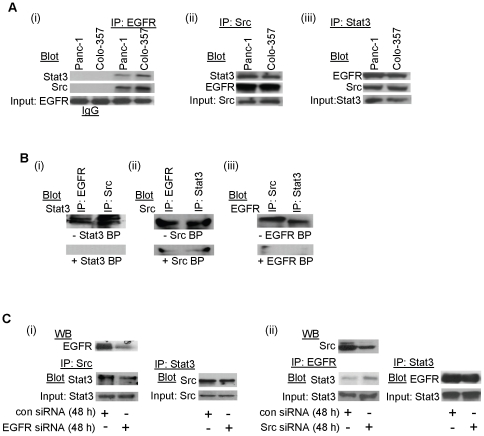
Co-immunoprecipitation with immunoblotting analysis of EGFR, Src and Stat3 association in Panc-1 and Colo-357 cells.Immunoblotting analyses of immunecomplexes of EGFR (IP:EGFR), Src (IP:Src), and Stat3 (IP:Stat3), or of non-specific IgG non-immunoprecipitate prepared from whole-cell lysates of Panc-1 or Colo-357 cells untransfected (A and B) or transfected with EGFR siRNA, Src siRNA, or control (con) siRNA (C) and probing for Src, Stat3 and EGFR in the absence (A and C) or presence (B) of Stat3 blocking peptide (Stat3 BP), Src blocking peptide (Src BP) or EGFR blocking peptide (EGFR BP). Bands corresponding to proteins in gel are shown; input: except where indicated, represents the immunoblotting for the respective immunoprecipitated protein in the same amount of lysate used in the assay; Data are representative of 3 independent studies.